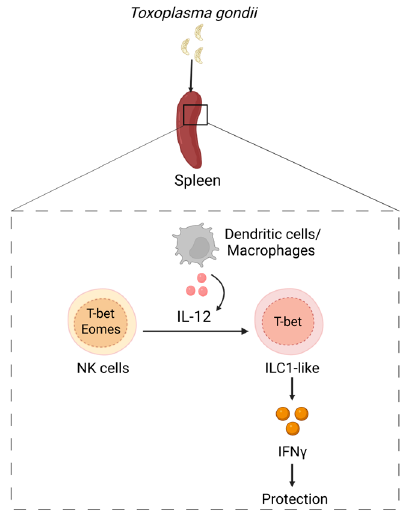
Figure 4. ILC plasticity in response to T. gondii . T. gondii activates dendritic cells and macrophages to produce IL-12 which drives NK → ILC1 plasticity in the spleen, liver and lungs by downregulating expression of Eomes. IFN γ is required for protection against T. gondii.